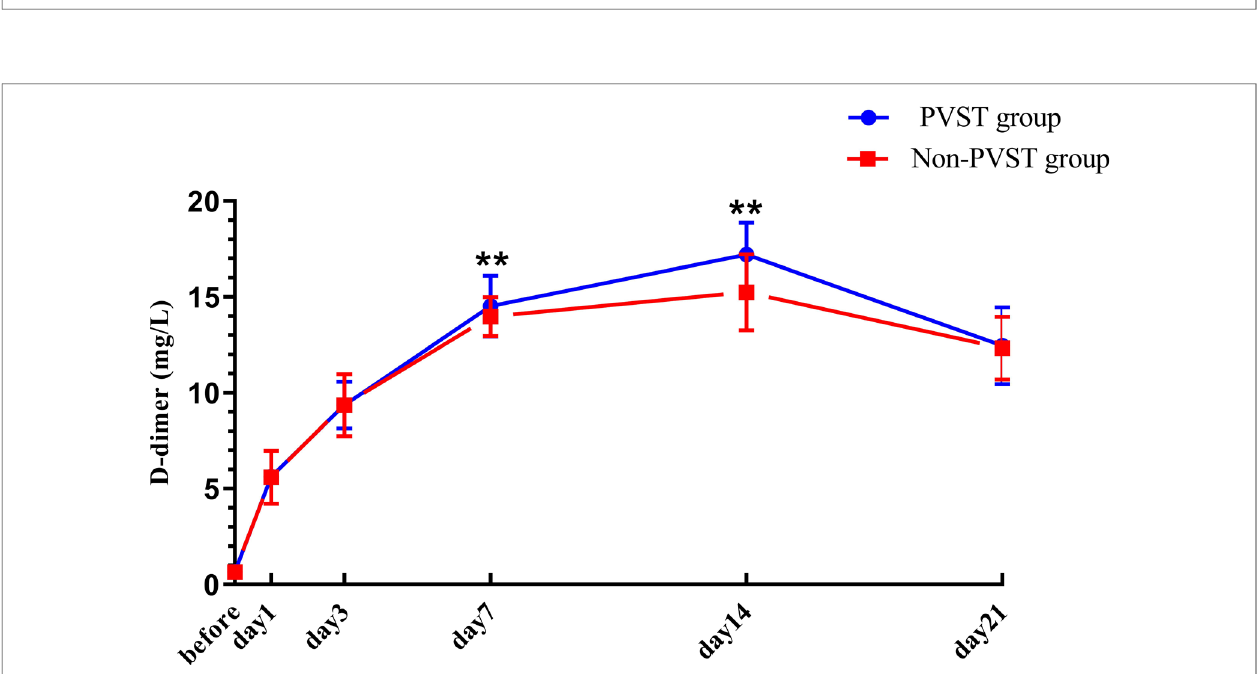
FIGURE 4 | The changes in D-D in Wilson ’ s disease during the perioperative period after splenectomy in the PVST and non-PVST groups. The perioperative changes in plasma D-D in the PVST and non-PVST groups were observed on the 7th and 14th days after surgery. Data were shown as mean±SD. F-all and P-all present the effect of interaction time and group from a repeated measurement linear model time points with differences between the two groups based on model-based pairwise comparisons as simple effects (Bonferroni). The symbol of “ ** ” indicates that the difference between the two groups is statistically signi fi cant ( Pp